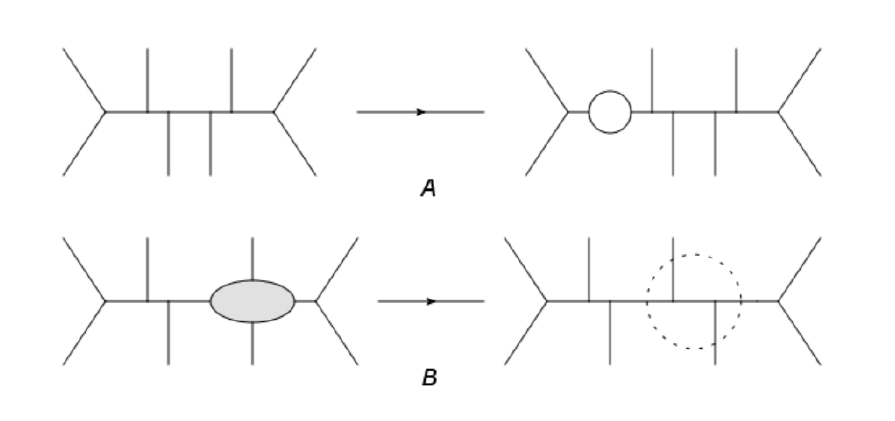
Figure 6 . (A) The way constructing one-loop diagram from tree. (B) The way constructing tree diagram from one-loop